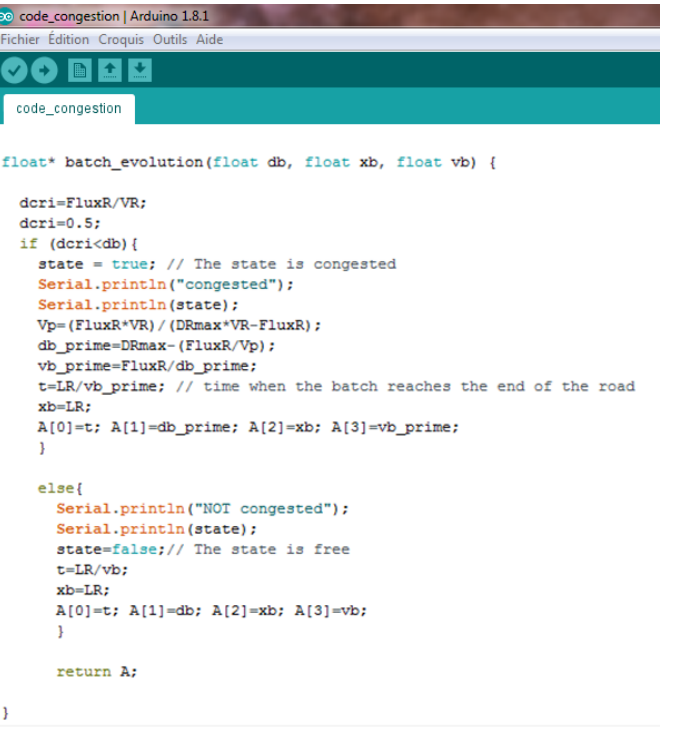
Figure 7. screen of the Arduino IDE program with a sample sketches loaded of GNBPN